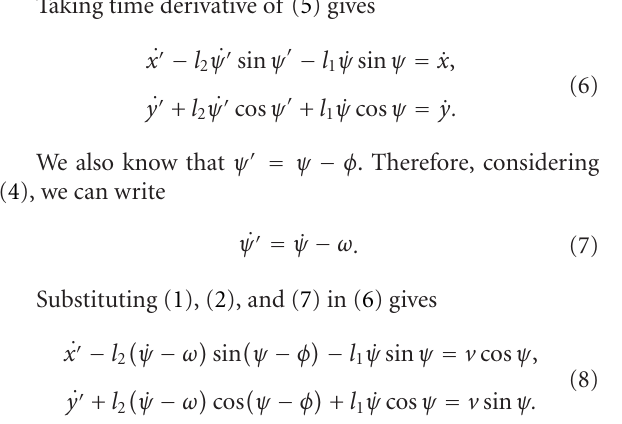
Figure 2: Diagram of a center-articulated mobile robot with respect to the target frame in Cartesian coordinates.